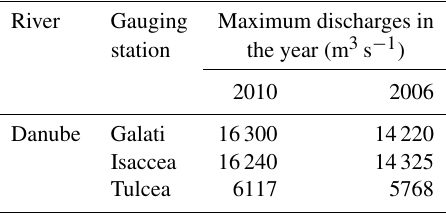
Table 5. Maximum discharges during flooding in the summer of 2010 for the Danube compared to the maximum values from